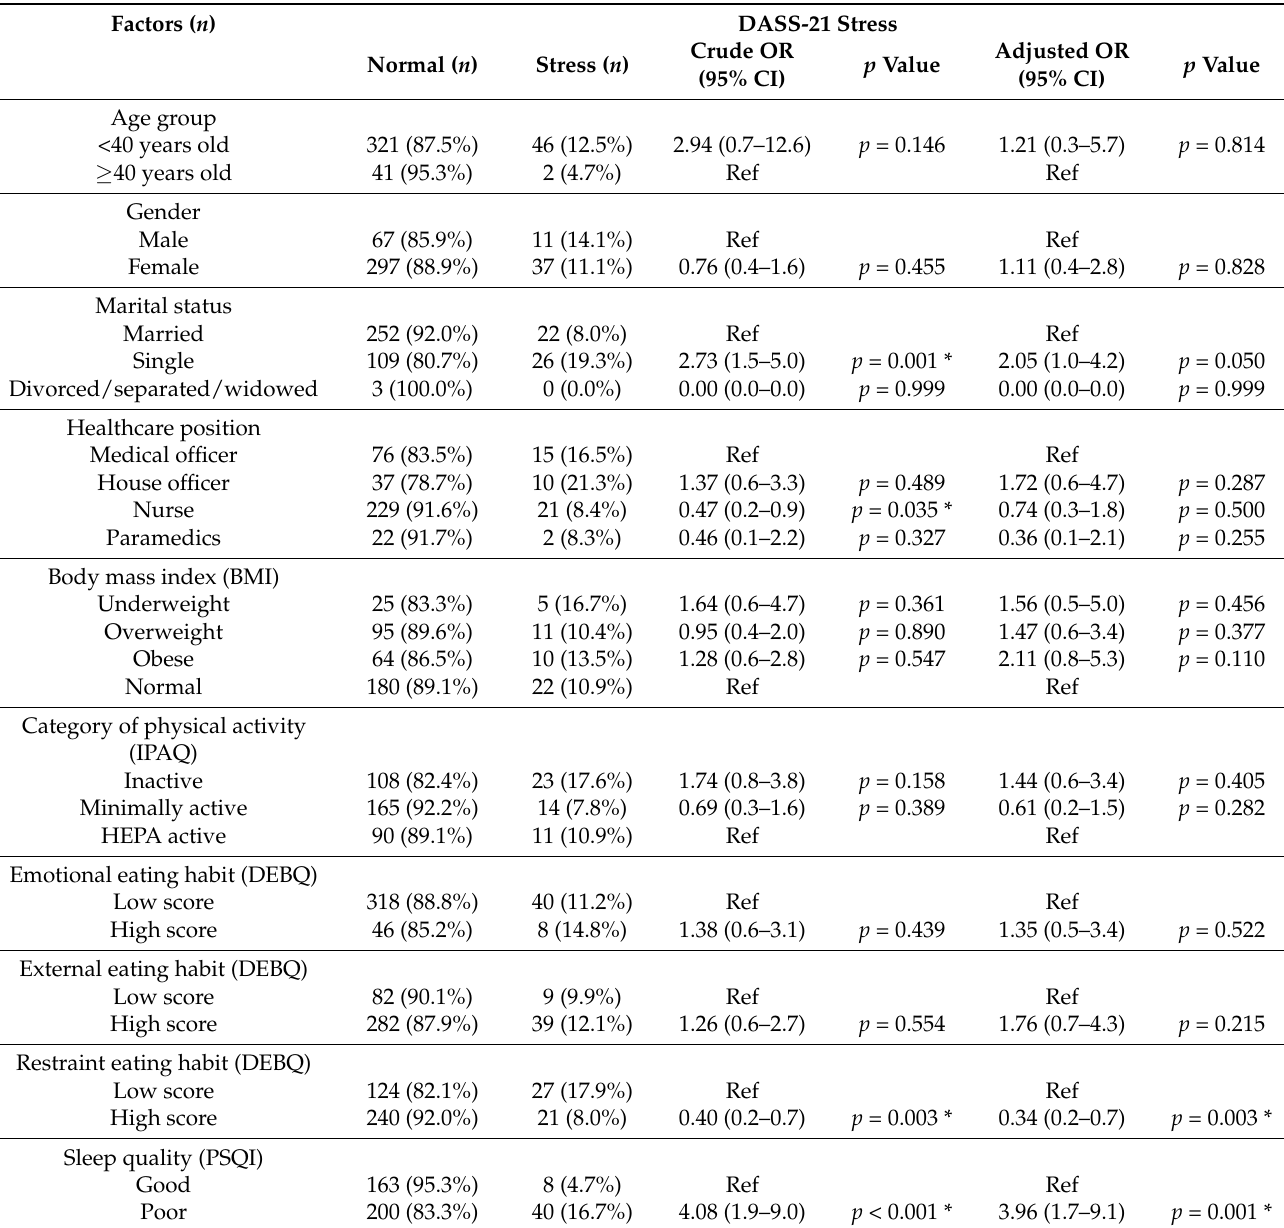
Table 5. The crude odds ratio (OR) and adjusted OR (AOR) for DASS-21 of